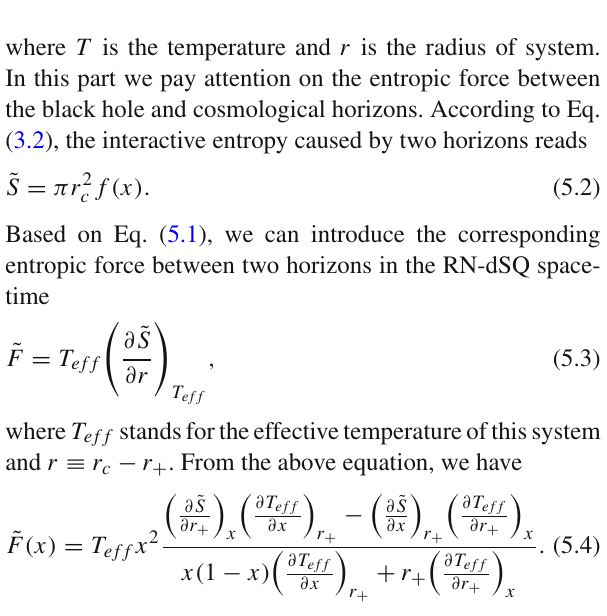
κ − P T eff ef f with different values of